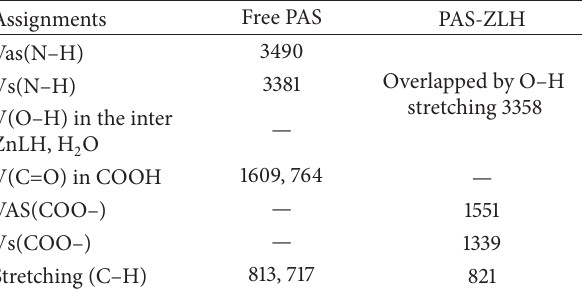
Table 1: FTIR functional group absorption bands of free PAS and its PAS-ZLH